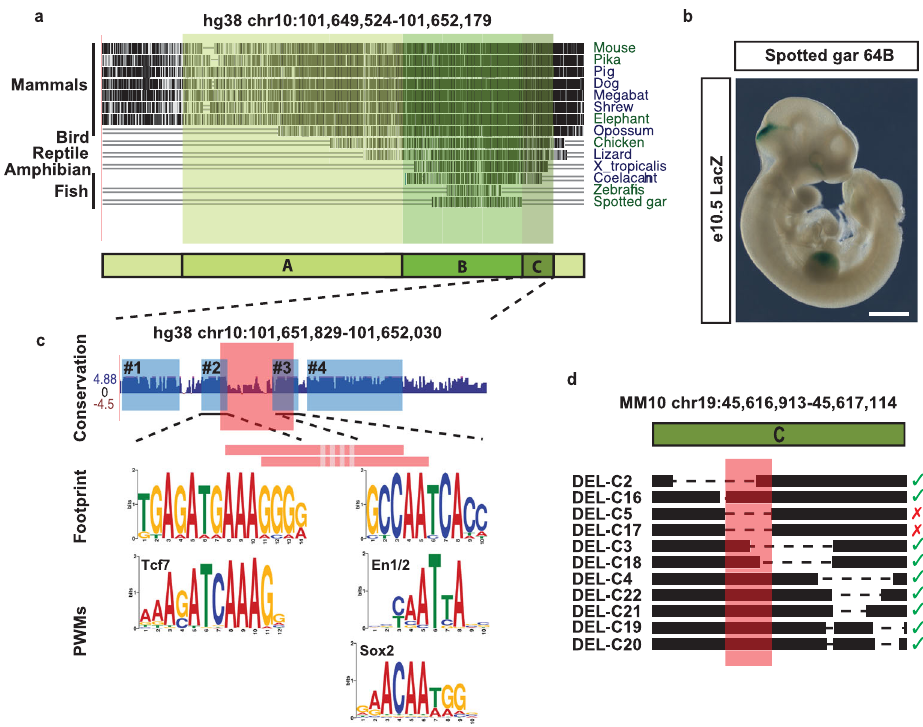
Fig. 6 Cross-species comparison reveals non-conserved essential features of mouse of CE64. a Sequence conservation of CE64 across species. 64-B is conserved from fi sh to mammals while 64-C is conserved among tetrapods. b Photomicrograph of a transgenic embryo injected with a minimal reporter construct including spotted gar CE64 and stained for LacZ activity ( n = 4, of which 4 displayed positive expression). Note that only 64-B is conserved in the spotted gar CE64. Arrowhead indicates the MHB. c Upper panel: sequence conservation score of 64-C. Blue boxes indicate highly conserved blocks. Red box indicate the smallest deletion that abrogates CE64 function. Middle panel: phylogenetic footprints generated from multiple sequence alignments corresponding to conserved block #2 and #3. The red bars indicate the breakpoints of the two smallest phenotype-causing deletions. Lower panel: PWMs of Tcf/Lef1, En1/2 and Sox proteins display similarities to the generated phylogenetic footprints. d Overview of small deletions in 64-C from the CRISPR/ Cas9 screen. Red box indicates 37 bp depicted in ( c ). Red cross indicates loss of MHB derived tissues and green tick indicates normal brain morphology. Scale bar in b is 1